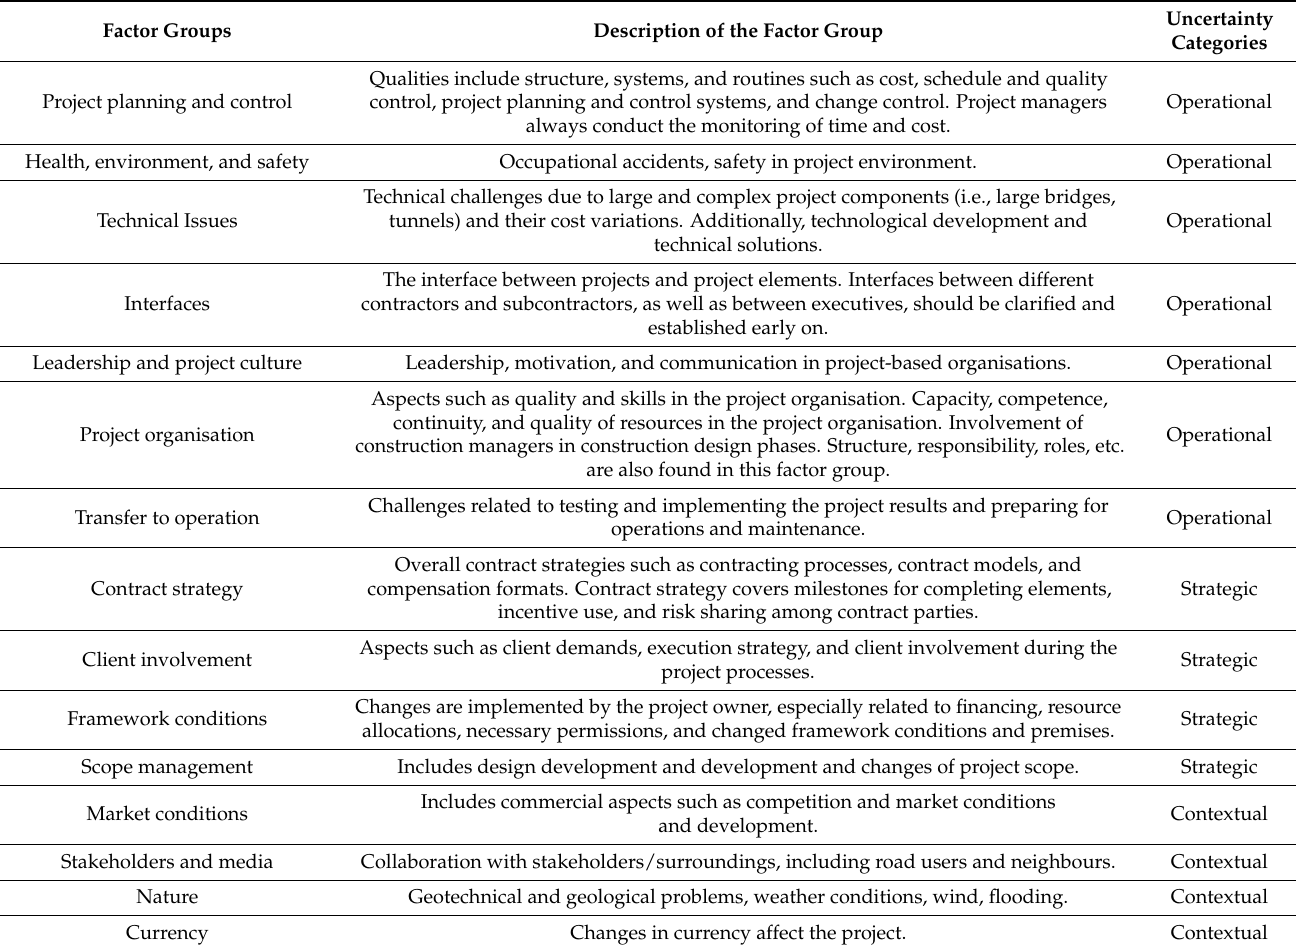
Table 1. Uncertainty categories for factor groups adopted from Torp et al.